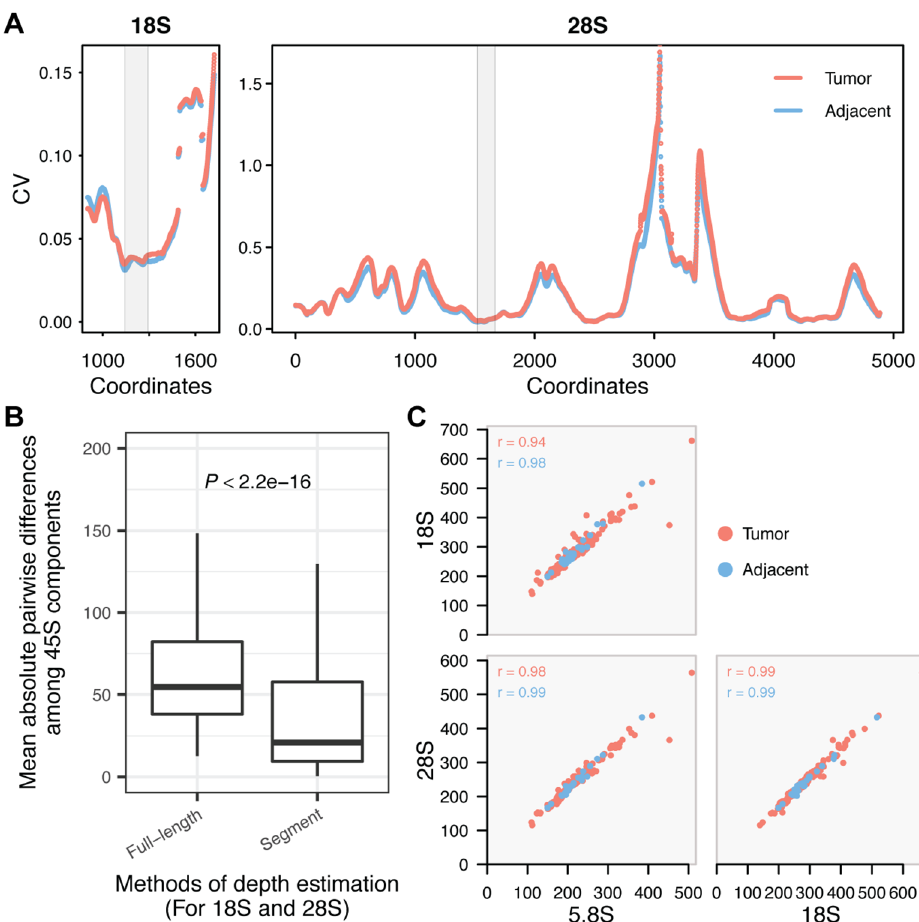
Fig 1. Estimating rDNA copy number. (A) For each 150bpswindowalong the rDNA array reference, we calculatedthe coefficientof variation(CV) of the averagedepth amongsamples. The x-axes indicatethe starting coordinatefor each windowon 18S (901–1871)and 28S (whole length).LUAD tumor and adjacent tissues have largely consistentCV across 18S and 28S sequences.The grey regions highlightthe windows selectedto assess CN in the 18S and 28S components. (B) The differencesin copy numberamongthe three 45S componentsin each sample were calculatedas the mean of their absolute pairwisedifference. Such differences are significantly smaller when using the selectedsegmentsthan using the full length of the rDNA shown in (A) for 18S and 28S. (C) Nearly perfect pairwisePearson correlations between45S components. BLCA is displayedas an example.Copy numberestimates are corrected for batch and ploidy.